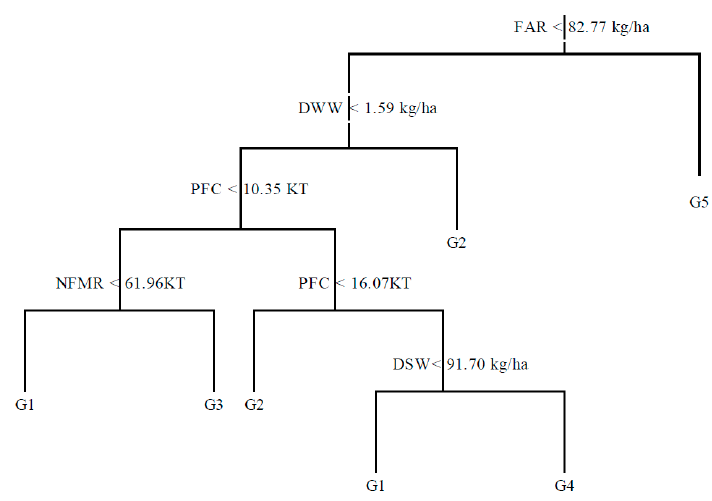
Figure 3. Decision tree on Hg concentration in farmland soil in China.